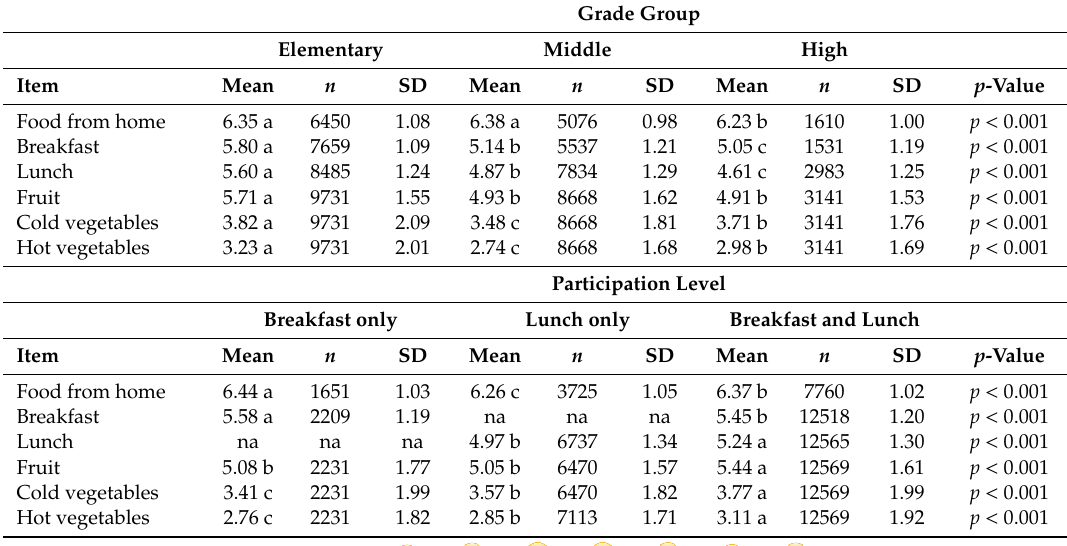
Table 1. Mean liking 1 of items in each food category 2 (by grade group and meal service participation). Grade